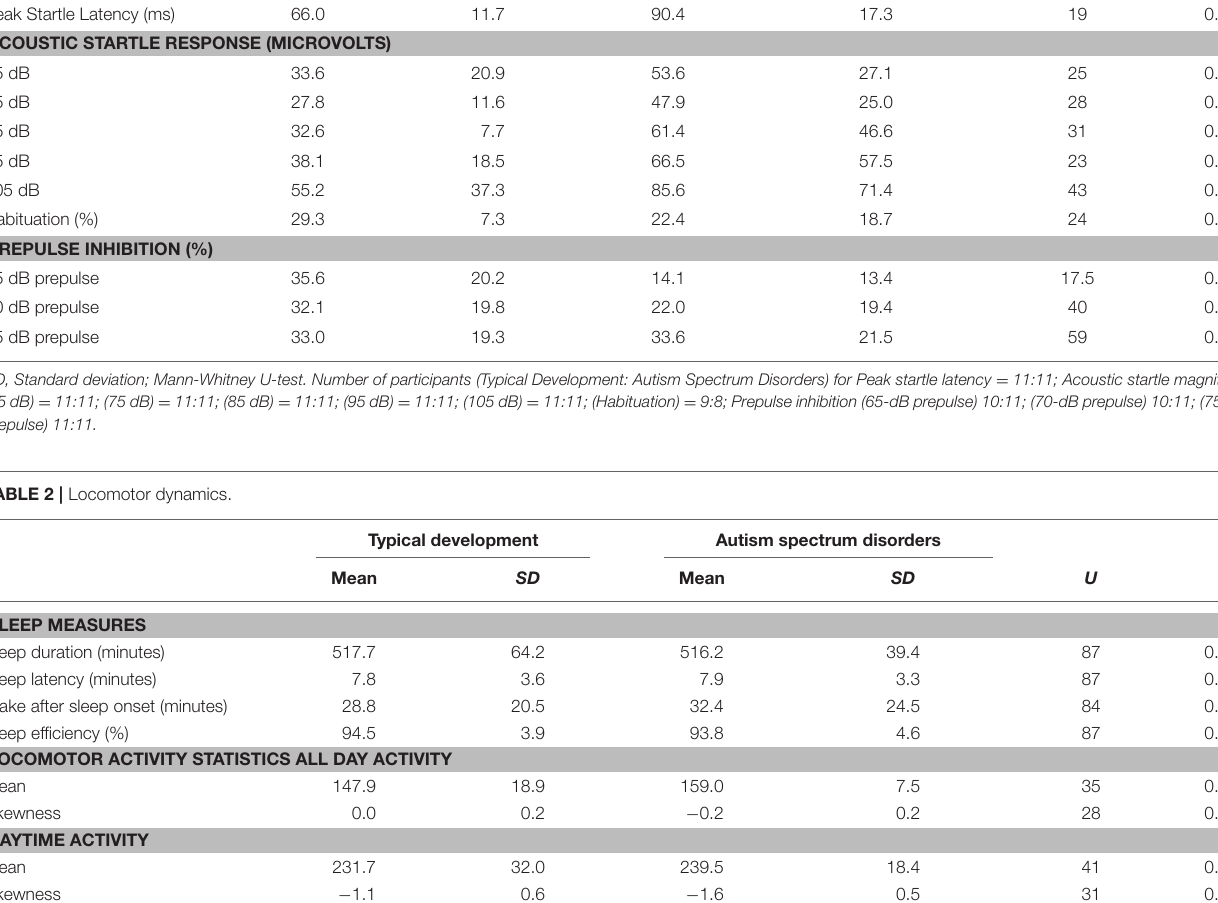
Typical development